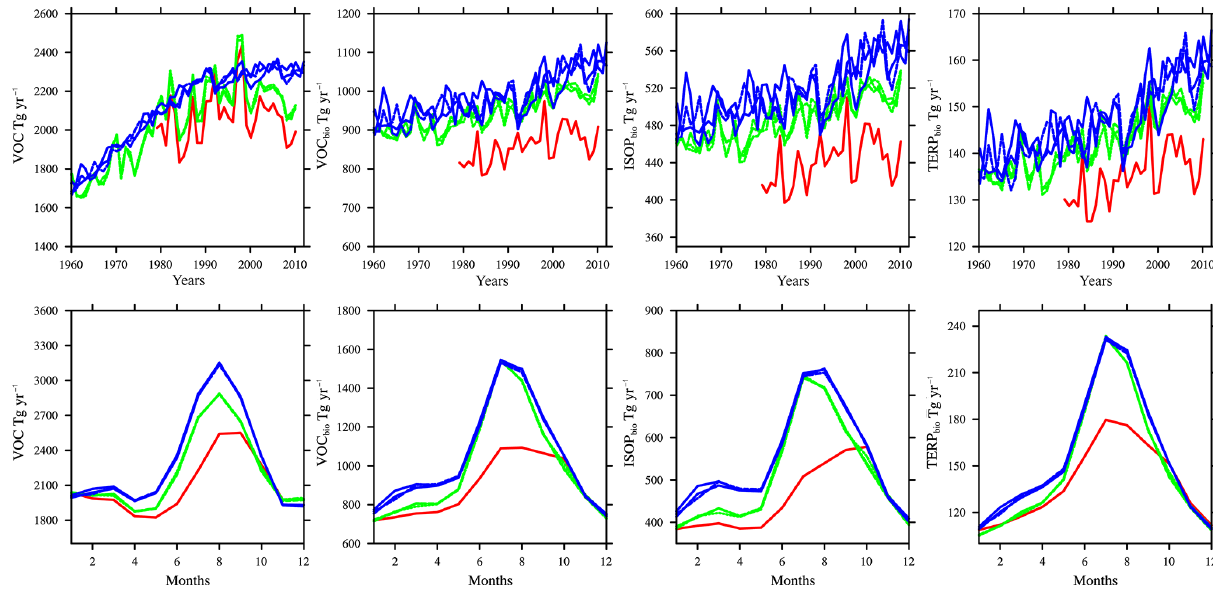
Figure 1. Global-averaged surface emissions of total volatile organic compounds (VOCs) (first column), biogenic VOCs (second column), biogenic isoprene (third column), and biogenic terpenes (fourth column), for different experiments, REFC1SD (red), REFC1 (green), REFC2 (blue). The seasonal cycle of zonal averages between 1960 and 2010 are shown at the bottom